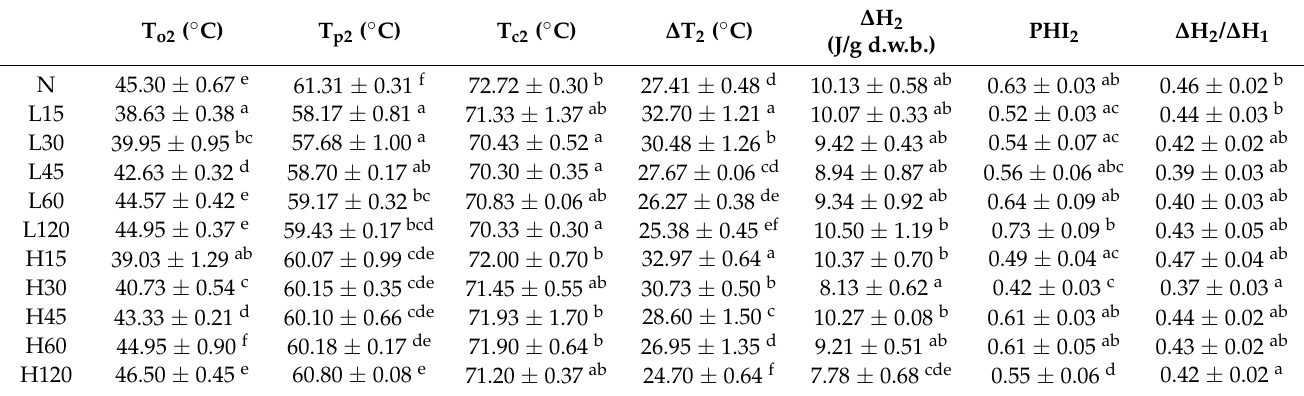
Table 5. Thermodynamic characteristics of the retrogradation of the native starch and distarch phosphates. T o2 ( ◦